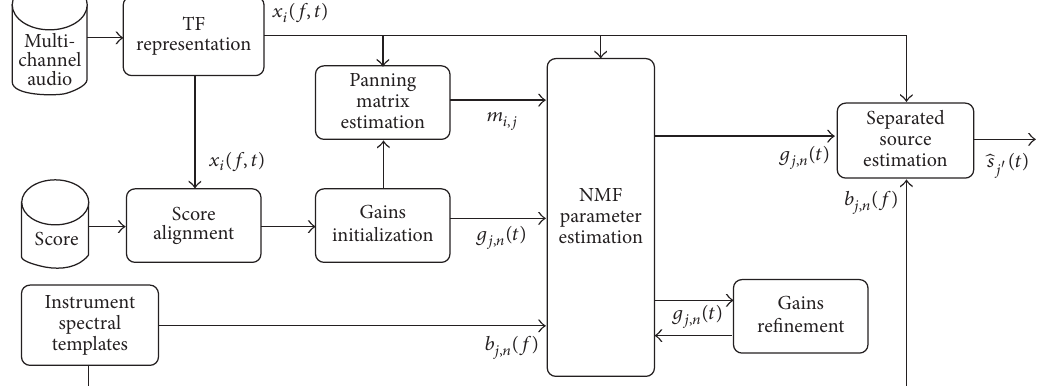
Figure 1: The diagram representing the flow of operations in the